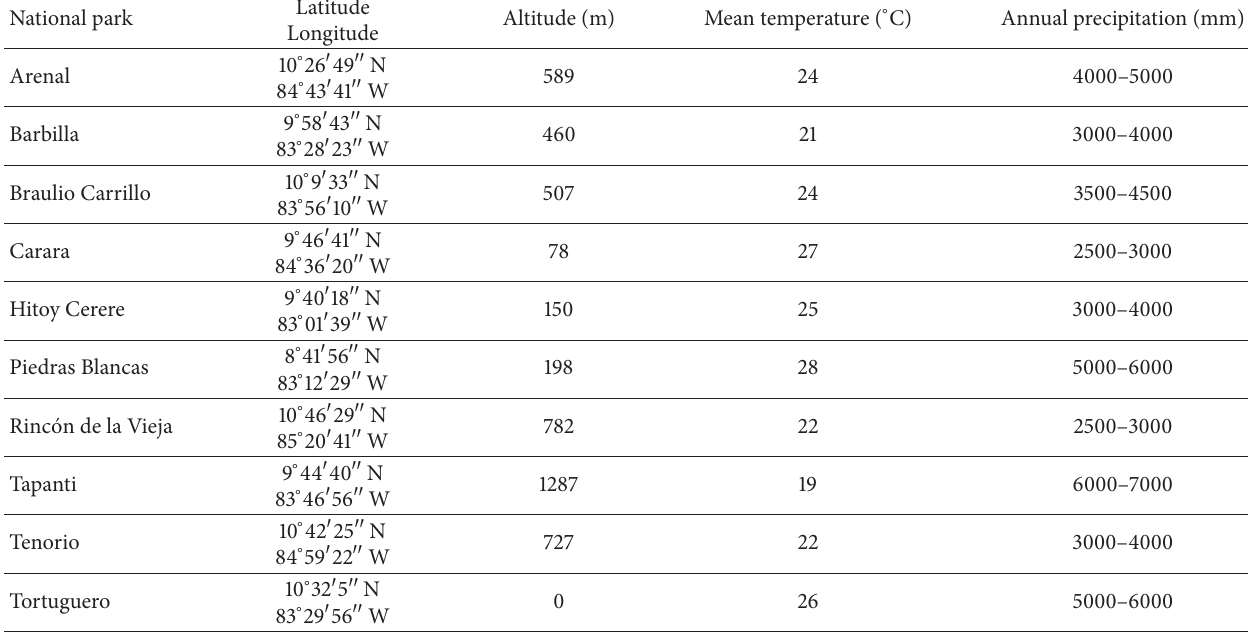
Table 1: Description of the location and main environmental parameters of the 10 national parks of Costa Rica, where sampling was carried out. The selected environments are classified as tropical wet forest and cover most of the natural distribution of the five coleopteran families studied.